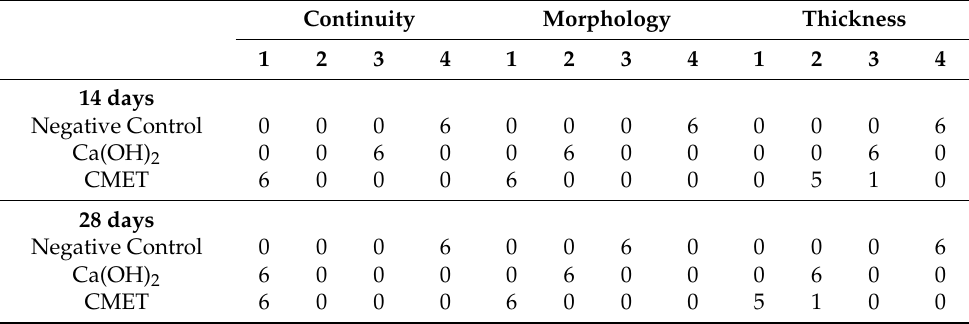
Table 1. Results of analysis of hard tissue